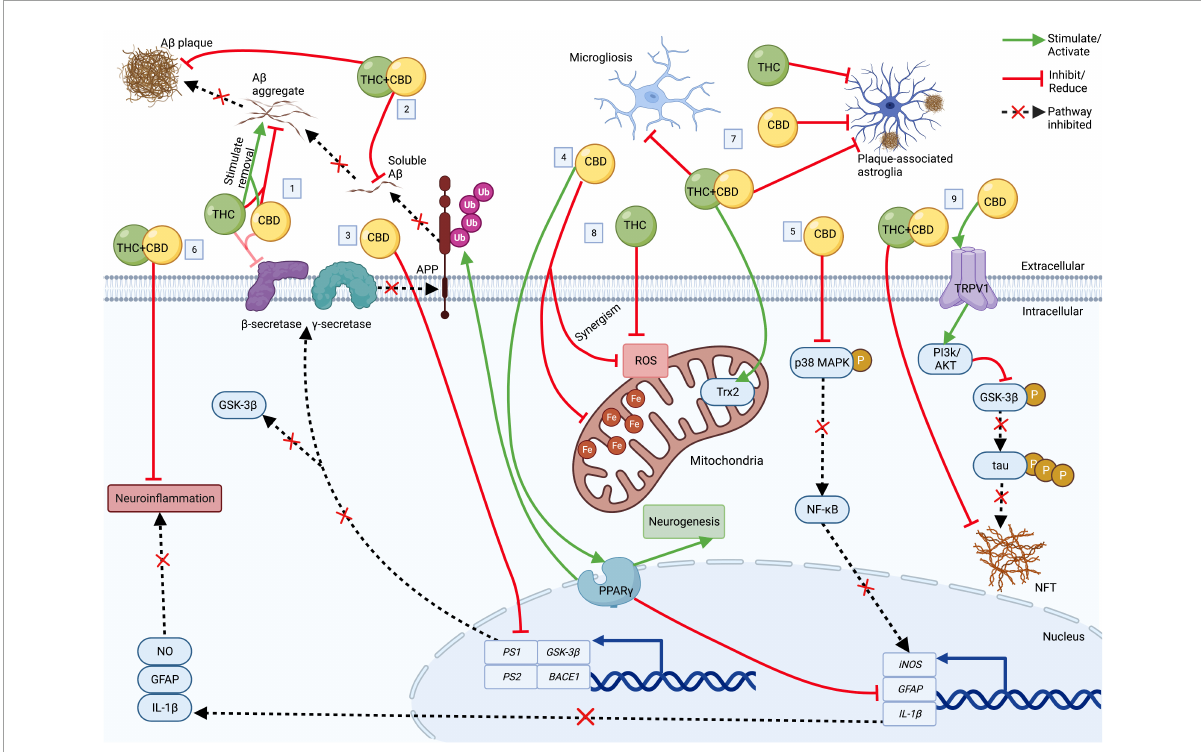
FIGURE1 The cellular effects of CBD, THC, and CBD+THC in AD. Top: Extracellular; Bottom: Intracellular. (1) CBD and THC each block A β deposition and ↑ aggregated A β removal. CBD and THC also (weakly) inhibit β -secretase. (2) CBD+THC ↓ A β plaques and soluble A β 42 . (3) CBD ↓ transcription of PS1 , PS2 , BACE1 , and GSK-3 β , resulting in ↓ enzymes involved A β and tau production. (4) Acting via PPAR γ , CBD (a) induces APP ubiquitination, resulting in ↓ A β , (b) ↑ neurogenesis, and (c) ↓ neuroinflammation by suppressing GFAP , IL-1 β and iNOS expression. (5) CBD also ↓ iNOS via p38 MAPK and NF- κ B. (6) CBD+THC also ↓ neuroinflammation. (7) CBD, THC, and/or CBD+THC ↓ astrogliosis and microgliosis. CBD+THC also ↑ Trx2. (8) CBD and THC ↓ ROS (with some potential synergism). CBD also ↓ mitochondrial ferritin. (9) CBD ↓ tau hyperphosphorylation via a TRPV1/ PI3K/AKT/GSK-3 β axis. CBD+THC also ↓ NFT. A β , Amyloid- β ; APP, amyloid precursor protein; AD, Alzheimer’s disease; BACE1, β -secretase 1; CBD, cannabidiol; Fe, ferritin; GFAP, glial fibrillary acidic protein; GSK-3 β , glycogen synthase